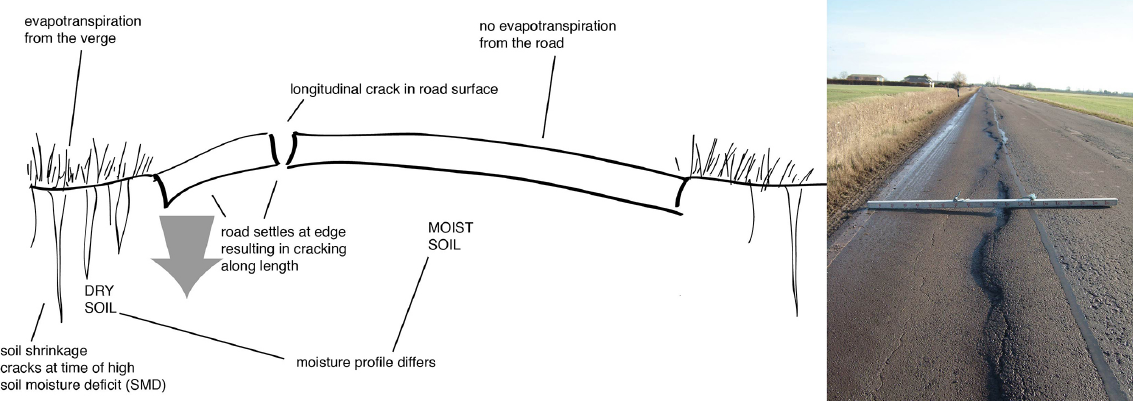
Figure 2. Soil processes leading to longitudinal cracking of road surface with photo example from Fodder Dyke, Lincolnshire (photo: Lincolnshire County Council, reproduced with permission; figure adapted from Pritchard et al., 2014, reproduced with